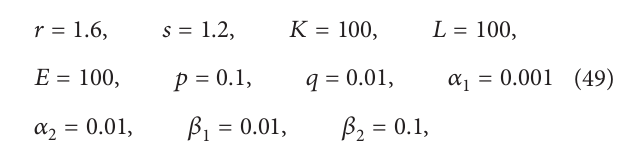
and versus for the values of parameters given 𝐵𝐵 𝑁𝑁 𝛿𝛿